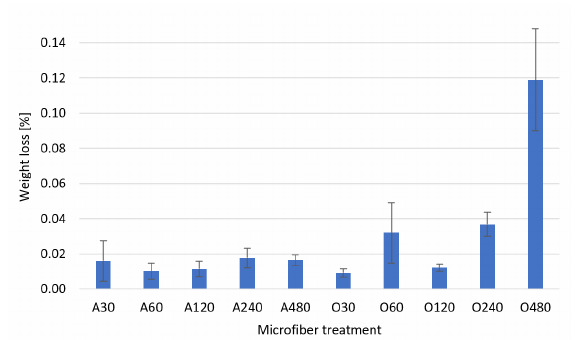
Figure 1. Percentage weight loss of microfibers af- ter argon and oxygen plasma treatment (A, O) and respective time in seconds (30, 60, 120, 240 and 480).